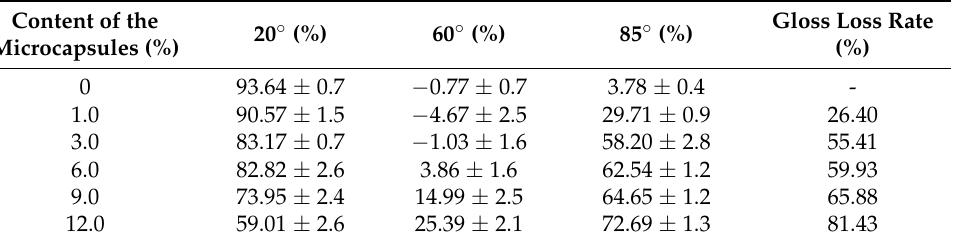
Table 14. Gloss and extinction rates of the paint films.